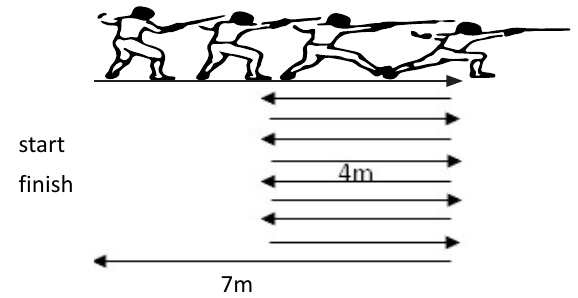
Figure 2. 7-m repeat lunge ability test Statistical Analysis